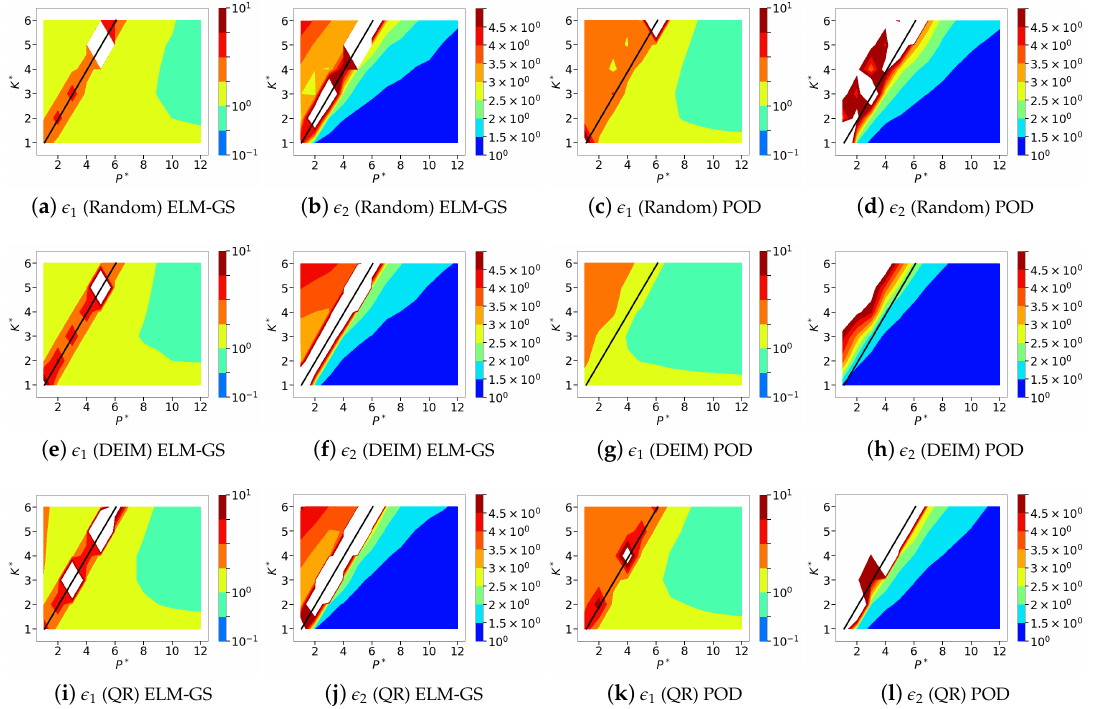
Figure 14. Isocontours of the normalized mean squared ELM-GS ( a , b , e , f , i , j ) and POD-based ( c , d , g , h , k , l ) sparse reconstruction errors ( l 2 norms) using random (top row), DEIM (middle row) and QR-pivoting (bottom row) sensor placements for sea surface temperature (SST) data. Left: normalized absolute error metric, (cid:101) 1 . Right: normalized relative error metric, (cid:101) 2 . The black line corresponds to P ∗ = K ∗ and separates the over-sampled form under-sampled